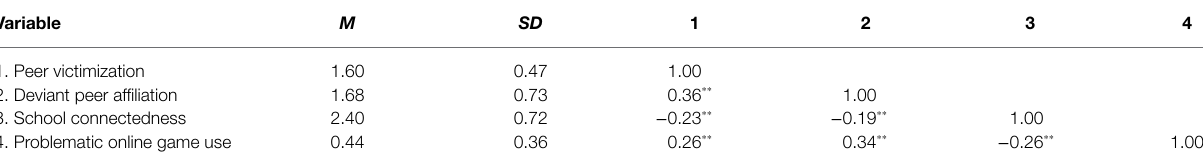
TABLE 1 | Descriptive statistics and intercorrelations between variables.